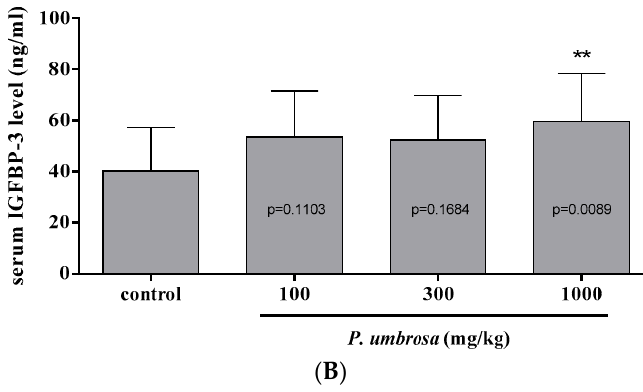
Figure 6. ( A ) Serum insulin-like growth factor-1 concentration for each group at 12 h after treatment; ( B ) Serum insulin-like growth factor binding protein-3 concentration for each group at 12 h after treatment. Each value is the mean ± SD. The number of animals is sixteen per group; ** p < 0.01 vs. control (one-way ANOVA, Bonferroni test).